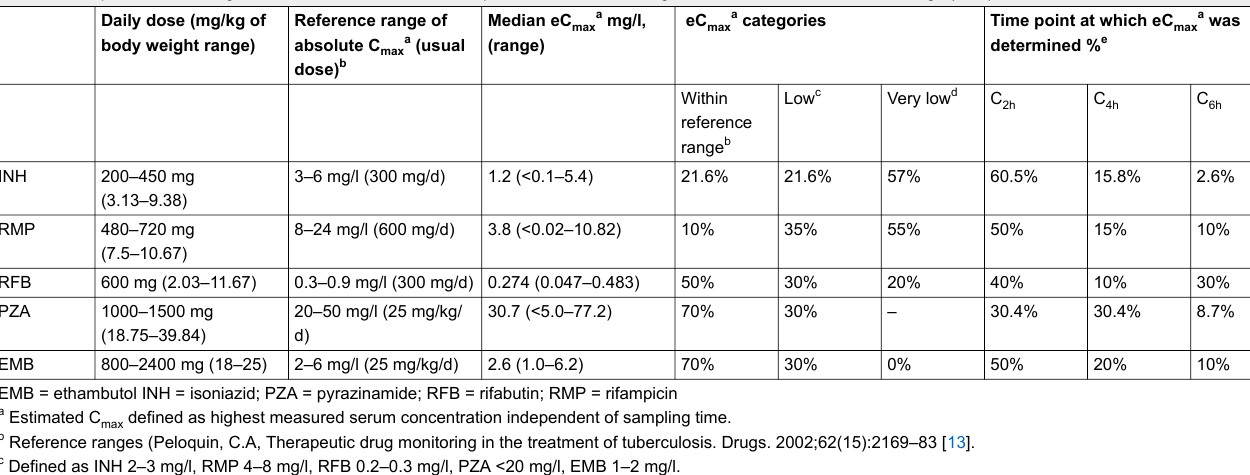
Table 3: Comparison and categorisation of estimated Cmax with published reference ranges for first-line antituberculosis drugs (ATD). Daily dose (mg/kg of body weight range)